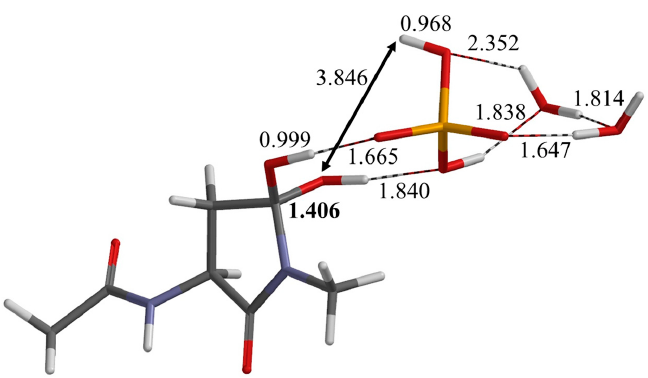
Figure 6. The geometry of the intermediate complex IC2. This complex is directly connected to TS2 (Figure 7). Selected interatomic distances are shown in Å. Grey: carbon; white: hydrogen; blue: nitrogen; red: oxygen; orange: phosphorus.